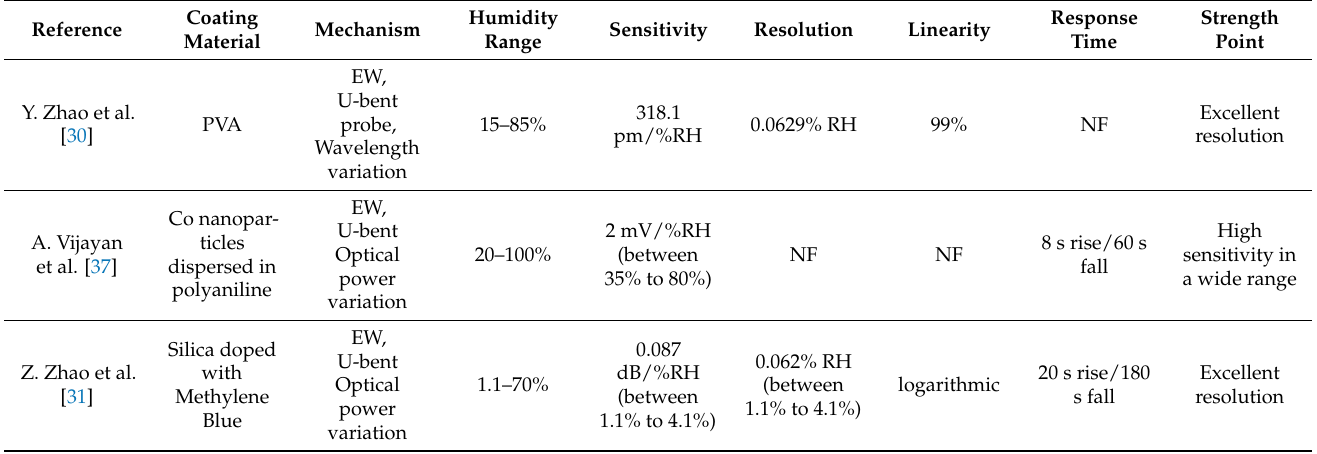
Table 3. Humidity sensors working based on the evanescent ‐ wave surface plasmon excitation principle reported in the literature.